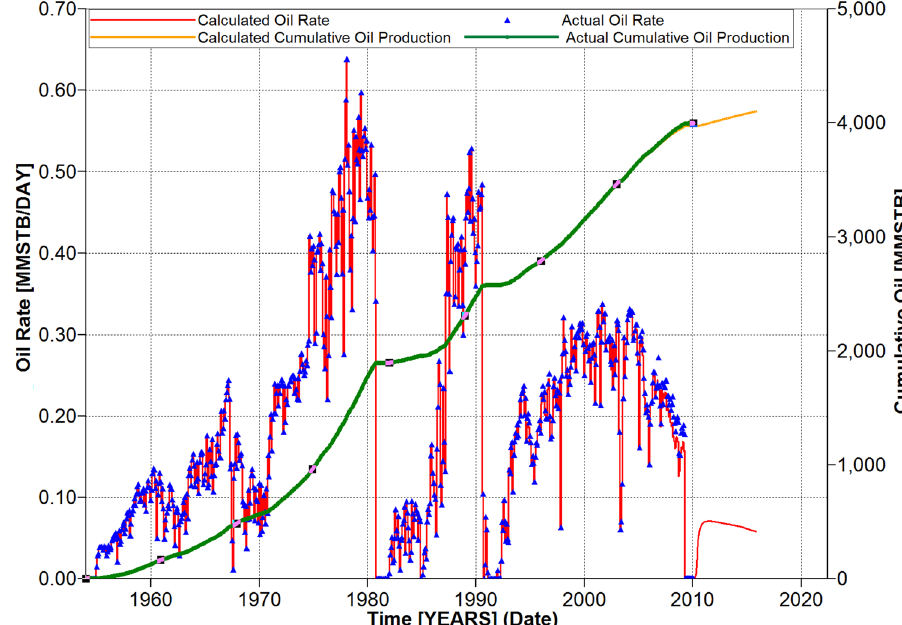
Fig. 5 History matching of entire field production of South Rumaila oil